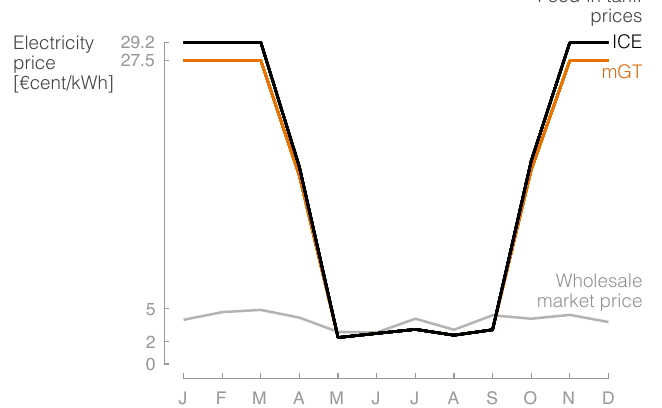
Figure 16. The feed-in tariff price during the winter is more than five times greater than the the wholesale electricity market